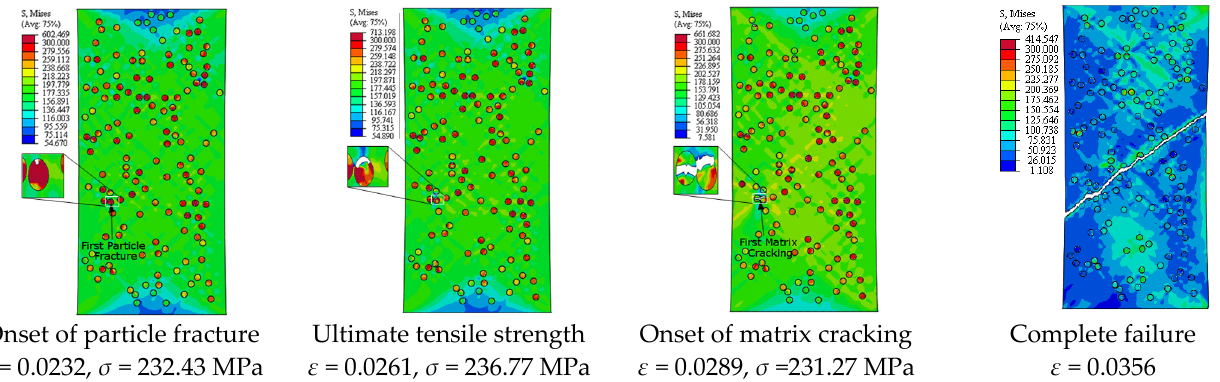
Figure 15. Failure propagation and von Mises stress distribution of A359/SiC composite at PS = 5 µm (10% VF).